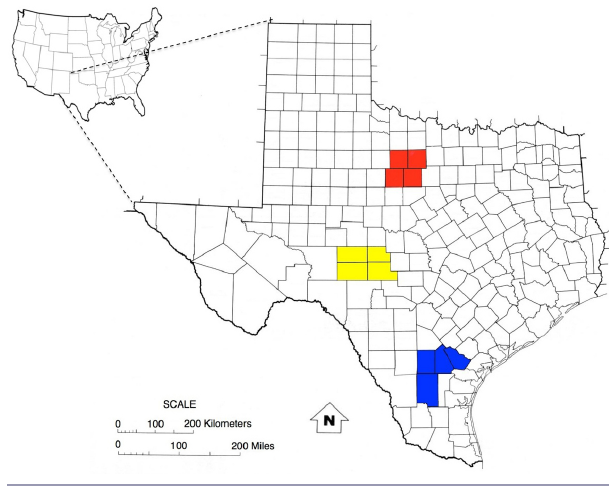
Fig. 2 . Location of counties in each of three ecoregions where data were collected. From north to south, the ecoregions include the Rolling Plains, the Edwards Plateau, and the South Texas Coastal